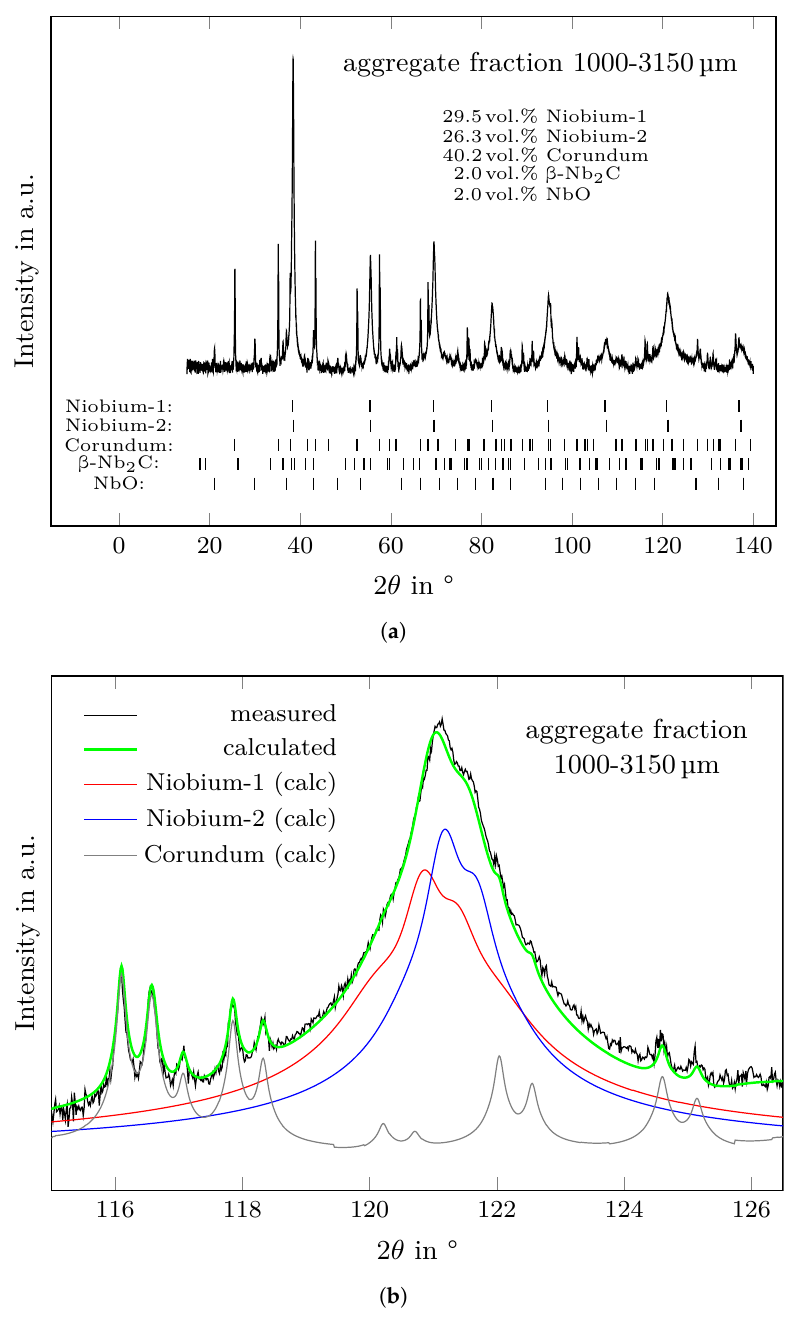
Figure 6. Results of XRD measurement and Rietveld refinement of the 1000–3150µm aggregate fraction. ( a ) Determined diffraction pattern and calculated positions of each phase reflections between 15 and 140° 2 θ and ( b ) enlarged view showing the calculated intensities of the niobium (132)